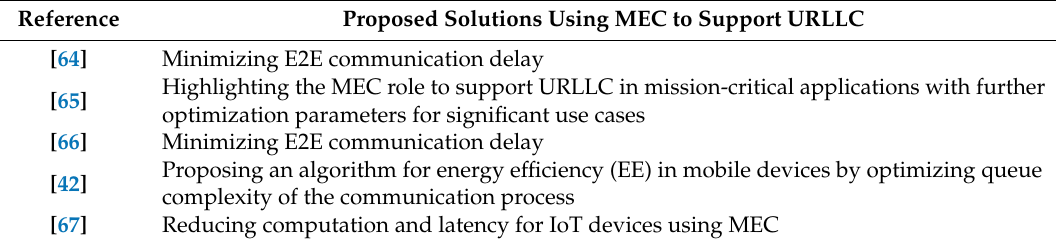
Table 8. Research towards the improvement of MEC with